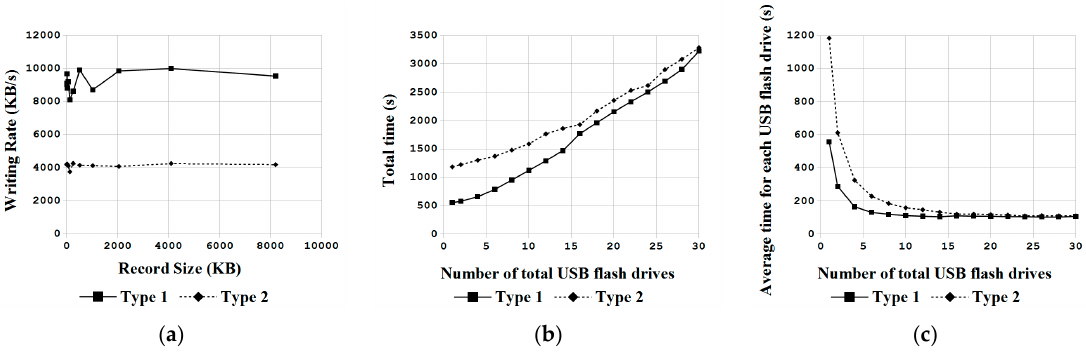
Figure 5. ( a ) Writing rate for two types of USB flash drives; ( b ) total time for deploying various number of USB flash drives; and, ( c ) average time for deploying various number of USB flash drives.